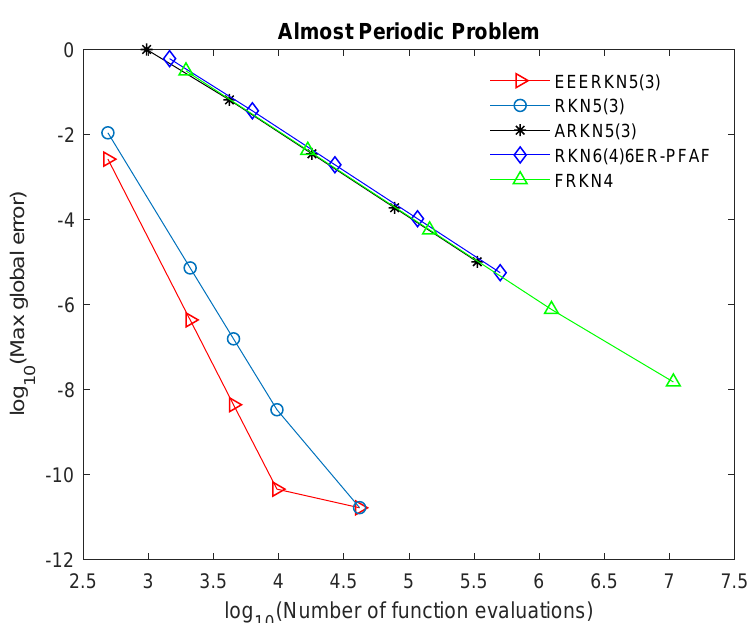
Figure 2. Efficiency curves for Problem 2.